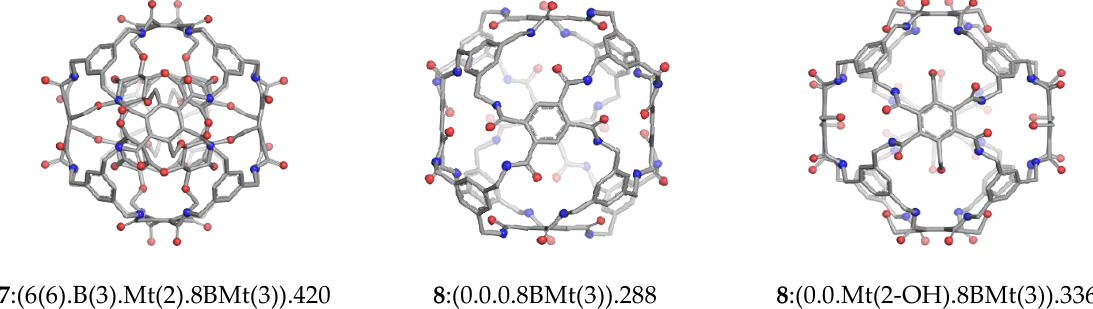
Figure 5. DFT optimized Cube-rhombellane structures: Cube-rbl-amide.420 (Tb2(1)) and its envelopes